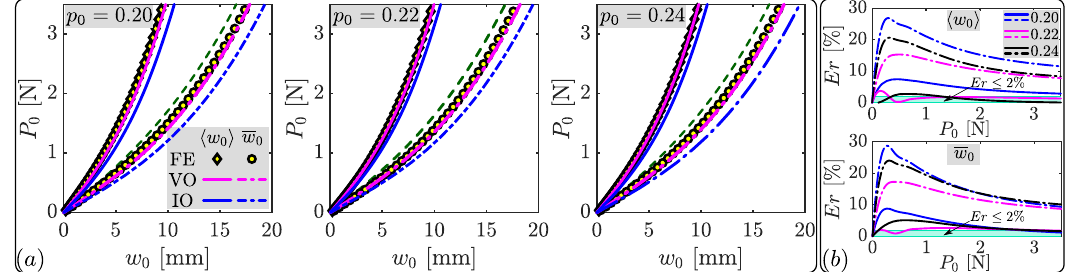
Fig. 4 Nonlinear thermoelastic response of the porous beams. a All the beams are subjected to a UDTL P 0 , an isothermal load θ = 100 K, and are clamped at both ends. The nonlinear response obtained via the three different methods are compared in terms of the average transverse displacement ( 〈 w 0 〉 ) and the transverse displacement of the geometric center ð w 0 Þ . Response of the center of the beam in the absence of thermal loads (dashed dark-green line) is provided to highlight the consistent softening. b Relative error in the predictions of the VO (solid line) and IO (dashed line) models with respect to the FE results (considered as the ground 2 min run time. The FE models were run on a cluster with 2 × AMD